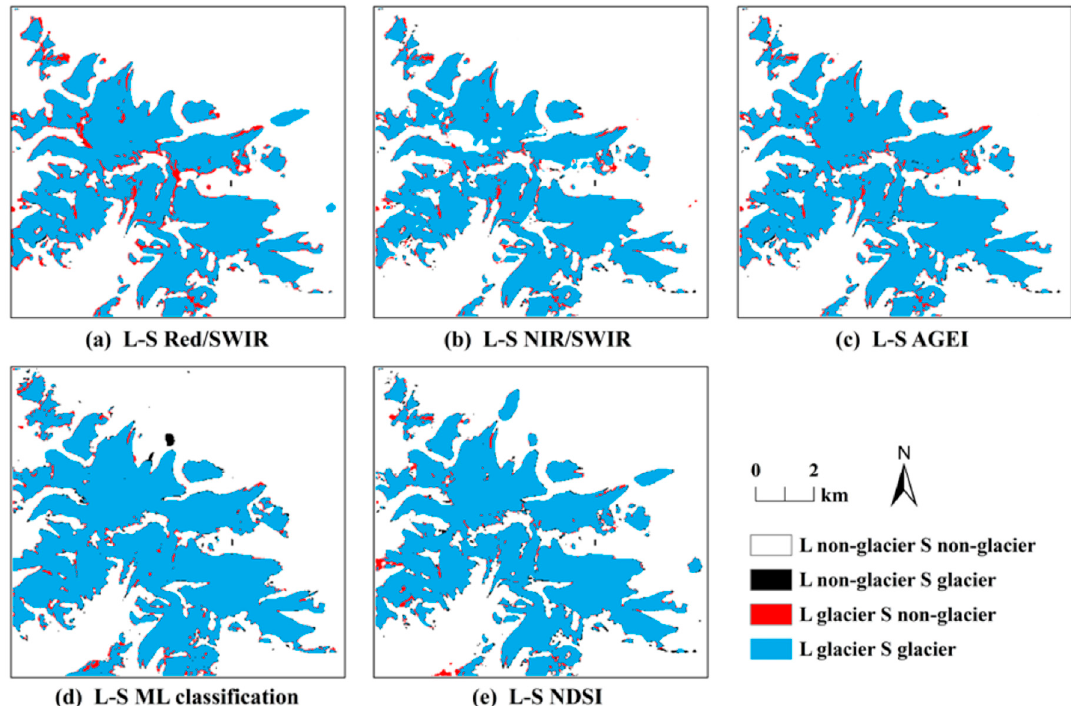
Figure 11. Overlaid glacier distribution map of Landsat 8 and Sentinel-2 imagery using five methods: